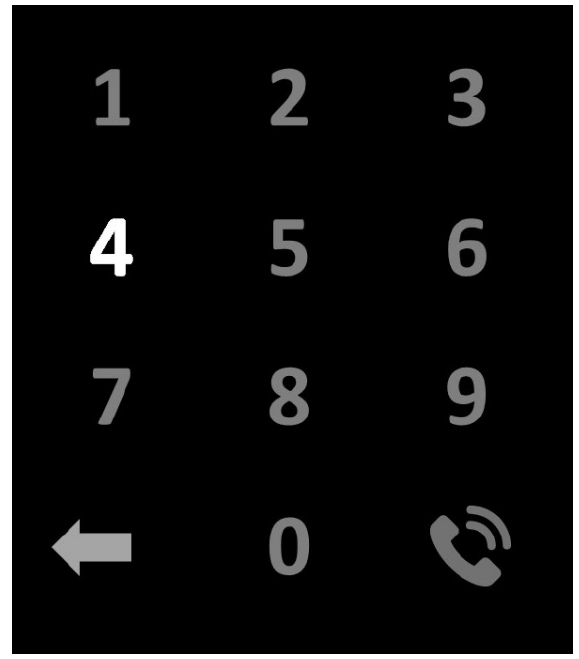
Figure 4. Secondary display for making phone calls.